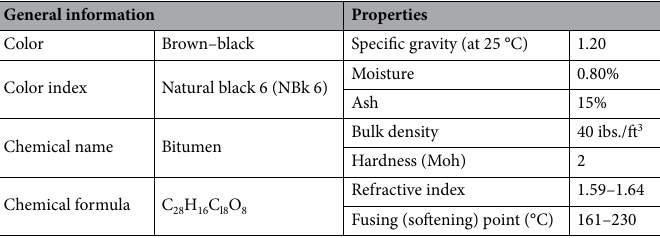
Table 2. Typical physical properties and characteristics of the gilsonite.